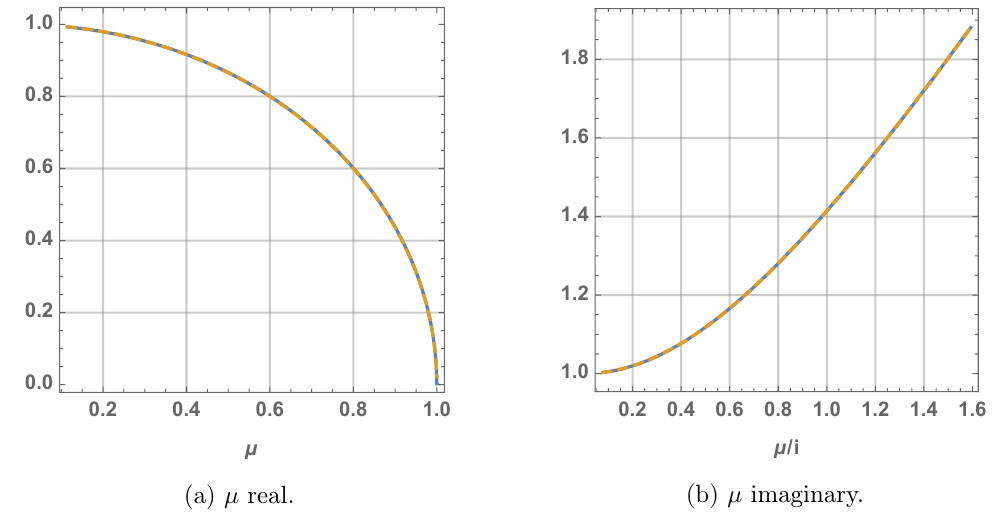
Figure 4. The yellow dashed curve shows numerical solutions for the on-shell action in (5.12) p divided by (cid:21) as a function of the parameter (cid:22) . The blue solid curve is a plot of the function p 1 (cid:0) (cid:22) 2 which should be compared to the field theory result in